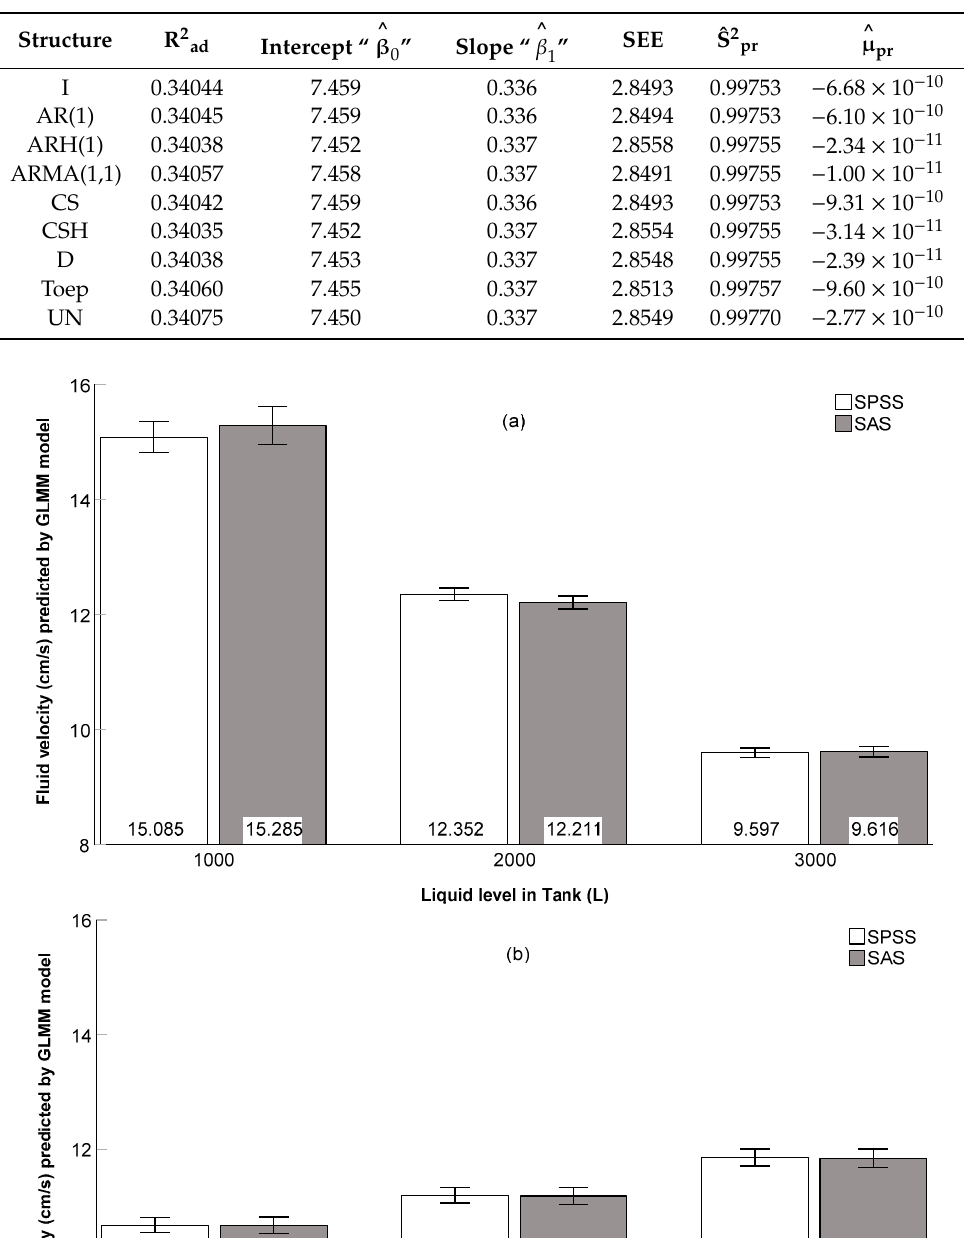
Table 6. Adjustment regression between the values observed and those predicted by the model; intercept and slope of the equation. R 2 ad : adjusted determination coe ffi cient; SEE: Standard Error of our Estimate; ˆS 2 pr : estimated Pearson residual variance; ˆ µ pr : estimated Pearson residual mean. P -value was < 0.001 in all items, according to the structure of the covariance matrix.